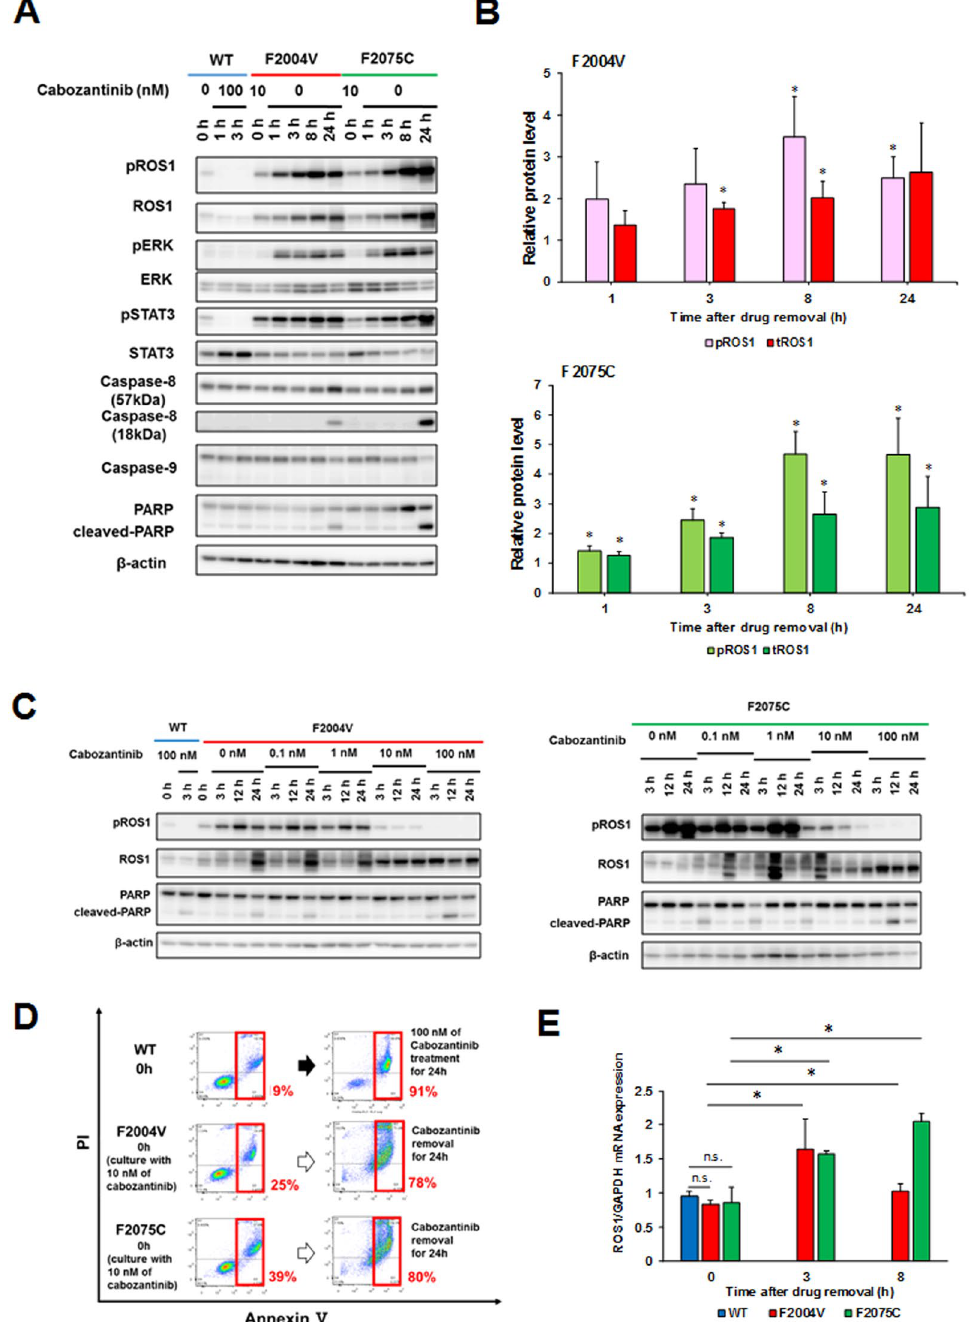
Figure 2. Increased ROS1 activity after removal of ROS1-TKI induces apoptosis. ( A , C ) Immunoblotting for F2004V- or F2075C-mutated cells without ( A ) or with cabozantinib at the indicated concentrations ( C ), or wild-type CD74-ROS1 cells treated with 100 nM of cabozantinib. Cell lysates were immunoblotted to detect the indicated proteins. ( B ) The graph indicates protein levels of total or phospho-ROS1 normalised with β -actin. The value at each time point is compared with F2004V-(top) or F2075C- (bottom) mutated cells in the initial state (0 h, in the presence of 10 nM cabozantinib); values are shown as mean ± standard deviation (SD) of three independent experiments (including the values of Fig. 2A). Statistical significance was calculated by a t test; * indicates p < 0.05 (compared with values at 0 h). ( D ) Apoptosis assay by flow cytometry for 100 nM cabozantinib-treated wild-type CD74-ROS1 cells and F2004V- or F2075C-mutated cells after removal of cabozantinib for 24 hours. The percentage of cells undergoing apoptosis is shown in red. ( E ) Expression levels of ROS1 or GAPDH mRNA in wild-type CD74-ROS1, F2004V- or F2075C-mutated cells were quantified using qRT-PCR. The graph indicates relative mRNA expression levels of each ROS1 that was normalised with GAPDH . Each value is shown as mean ± SD of three experiments. Statistical significance was calculated by a t test; * indicates p < 0.05 and n.s., p ≥ 0.05. Uncropped blots are presented in Supplementary Fig.